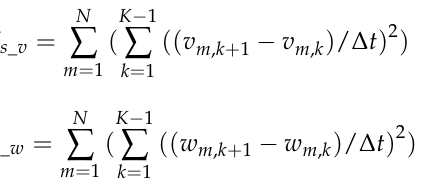
J and J are given as follows. _ s w _ s v